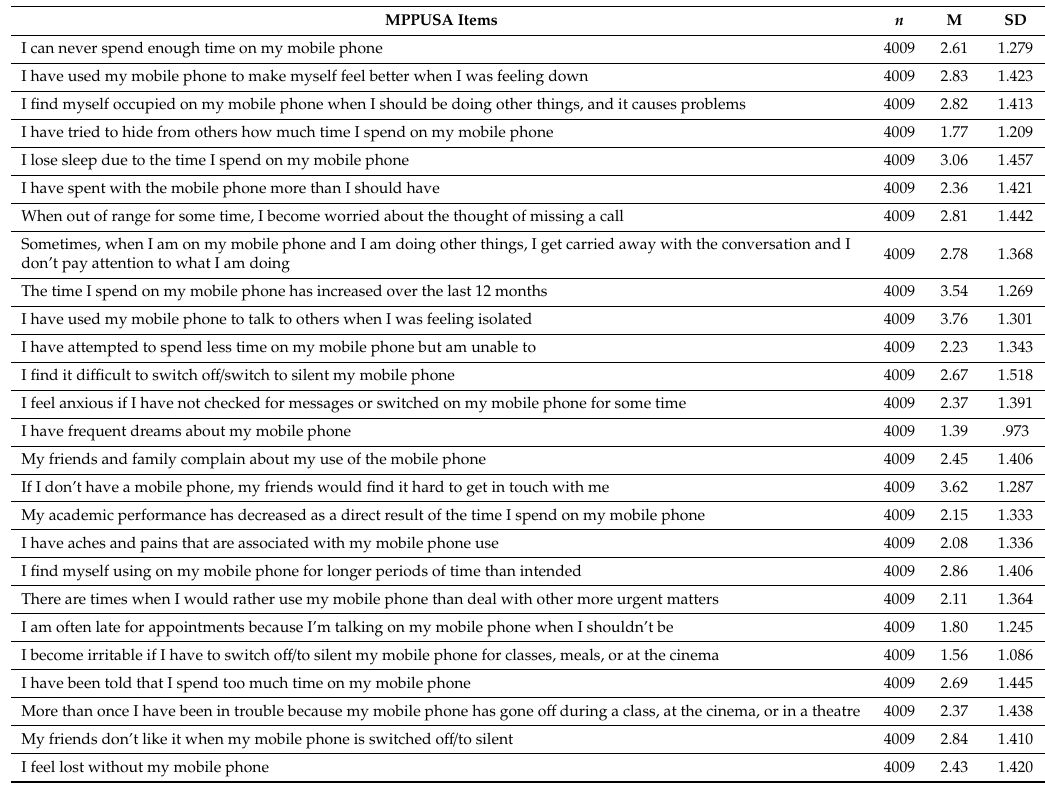
Table 2. Frequency distribution of the items from the MPPUSA